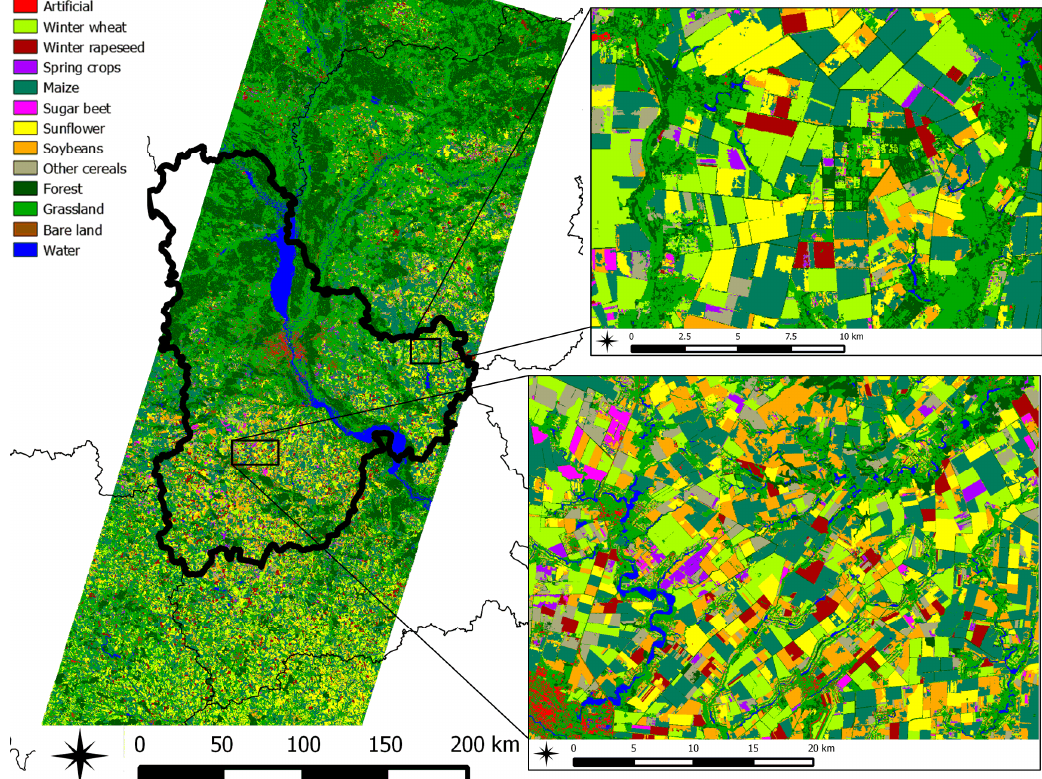
Figure 3. Final map obtained by classifying multi-temporal Landsat-8 imagery using a committee of MLP classifiers